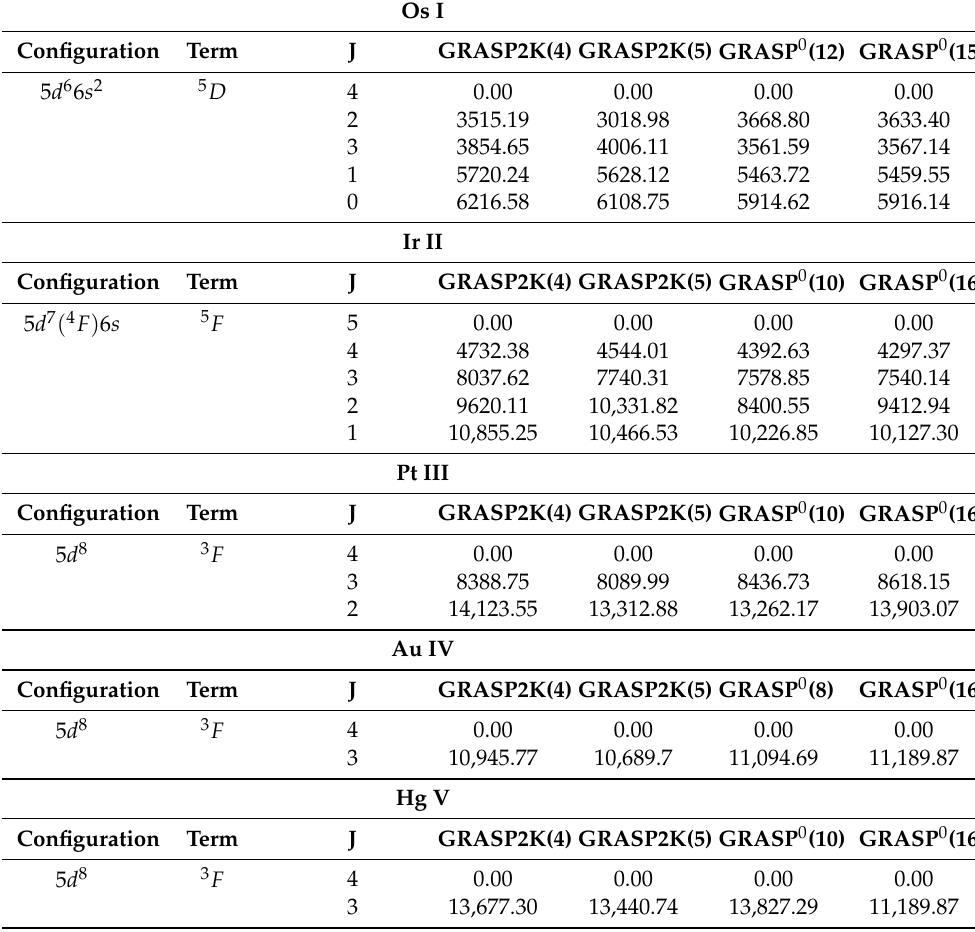
Table 4. Energy comparison of GRASP2K and GRASP 0 with different configurations as given in parentheses for the ground